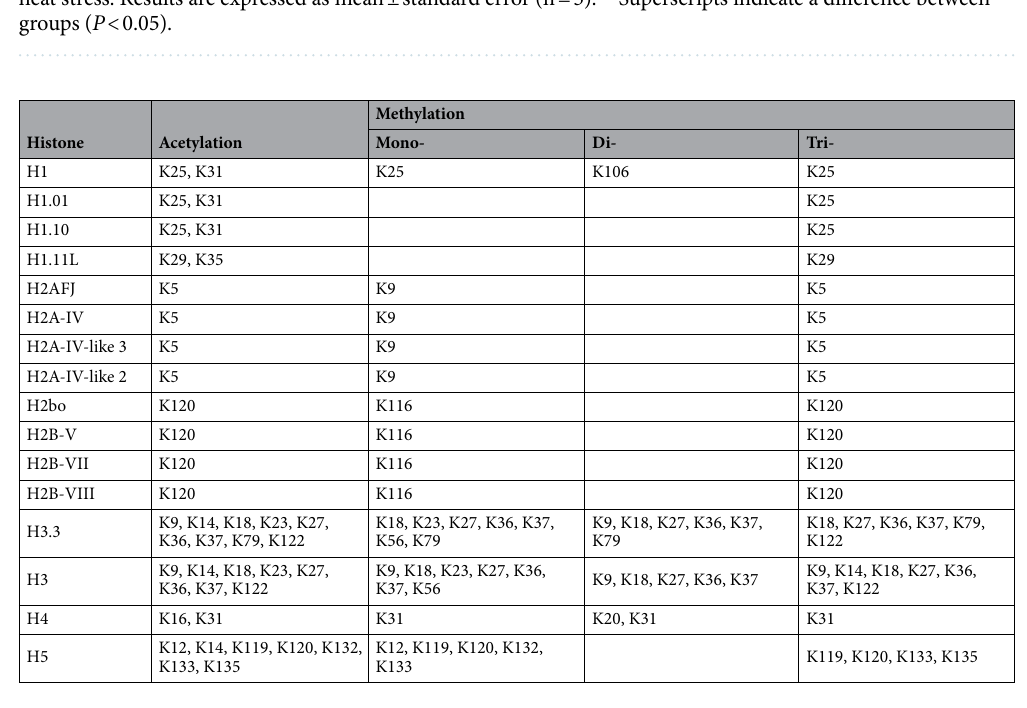
Table 2. Histone posttranslational modifications (PTMs) in the adrenal gland of male L2 strain